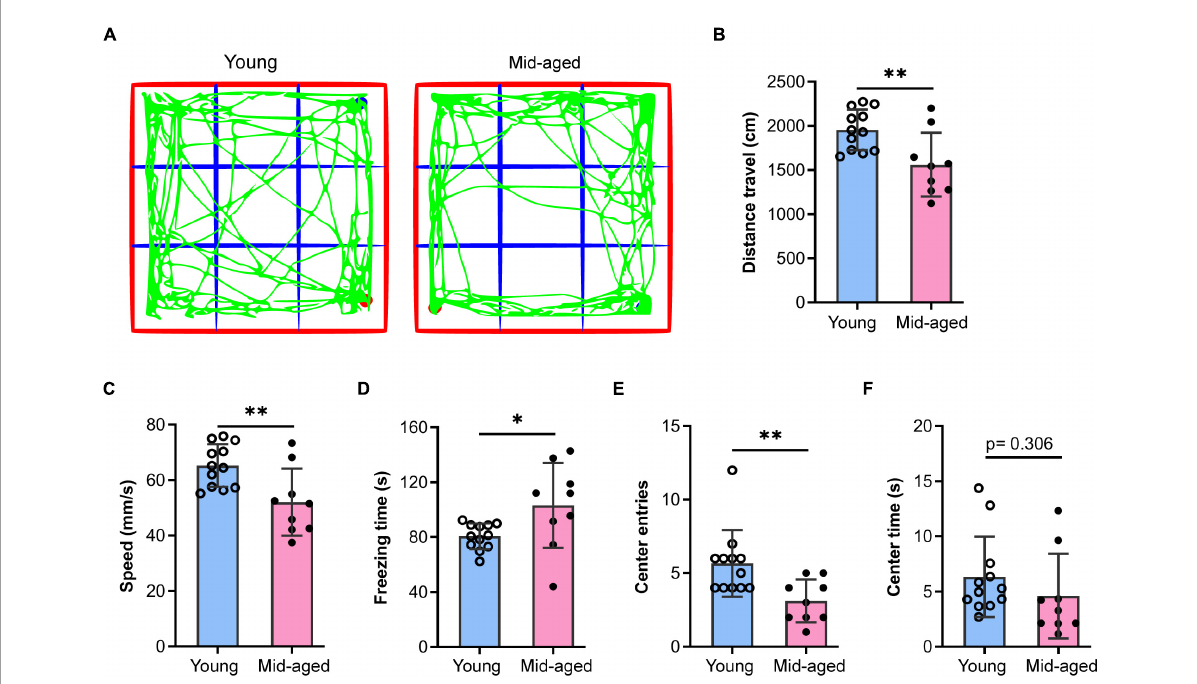
FIGURE1 Open field test to study the behaviors of young and middle-aged mice. (A) Representative trajectory of young or middle-aged (Mid-aged) male mice in the open-field test. (B–F) Statistic data of the open field test parameters. Data shown are means with SEM. The distance travel (B) , speed (C) , freezing time (D) , center entries (E) , and center time (F) were quantified by the Open field test during 5-min monitoring. Student’s t -test and the p -value were shown in each bar chart, ∗ p < 0.05, ∗∗ p < 0.01; the hollow dot and the solid circle show the sampling dataset collected from the young group ( n = 12) and the middle-aged group ( n = 9, Mid-aged).